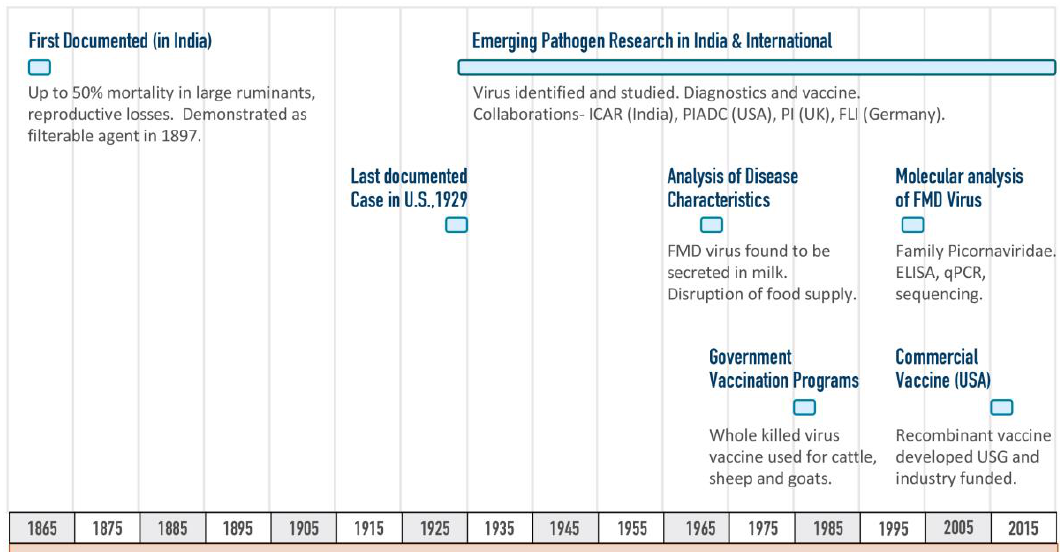
Figure 4. Timeline of the research and development of the foot-and-mouth disease (FMD) vaccine. This timeline shows highlights from early FMD discovery (focusing on India) to the licensure of a livestock vaccine [7,14,16]. The Friedrich-Loeffler Institut in Riems Germany (Figure 1) is the location of the first research work done on foot-and-mouth disease.